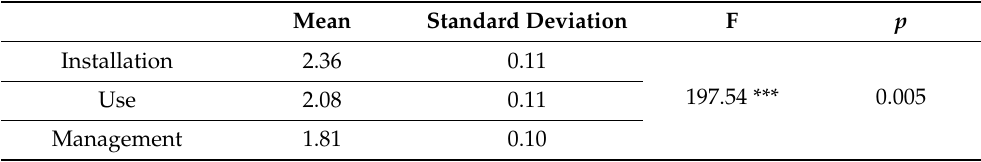
Table 9. Summary of Mobile Device Usability of Information